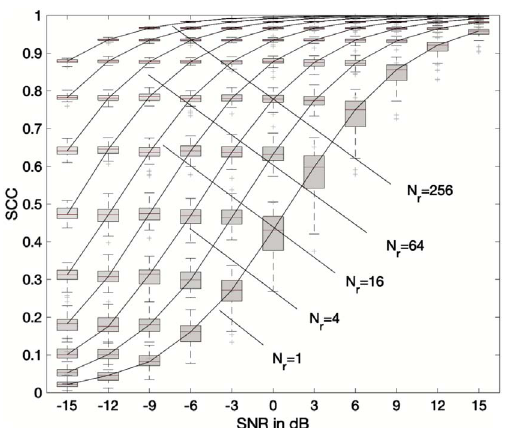
Figure 11. SCC between the original spectrum and the reconstructed spectrum of the source patch according to Equation (13) in the prediction as function of receiving positions and signal to noise ratio shown as boxplots. The curve indicates the median values. The lowest curve corresponds to 1 receiving position. The consequent curves correspond to 2, 4, 8, 16, 32, 64, 128 and 256 (highest curve) receiving points.